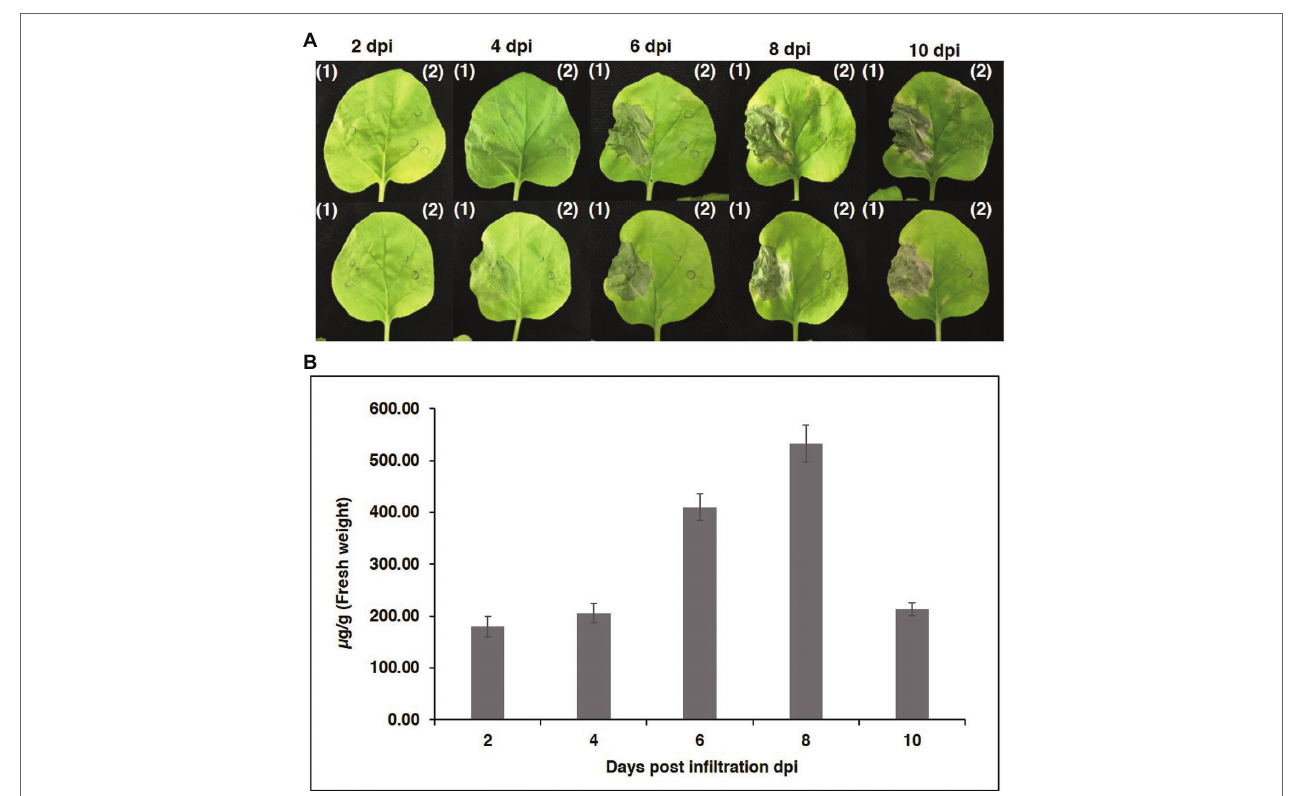
FIGURE 3 | Transient expression of anti-RANKL mAb in Nicotiana benthamiana leaves. (A) Phenotype of leaves on days 2, 4, 6, 8, and 10 after agroinfiltration. (1) N. benthamiana leaves were co-infiltrated with Agrobacterium tumefaciens harboring pBYK-2e-anti-RANKL HC + LC and (2) A. tumefaciens without an expression vector. (B) Infiltrated leaves were harvested on days 2, 4, 6, 8, and 10 from three individual plants each day post-infiltration and quantified by ELISA. The data are shown as the mean ± standard deviation (SD) of